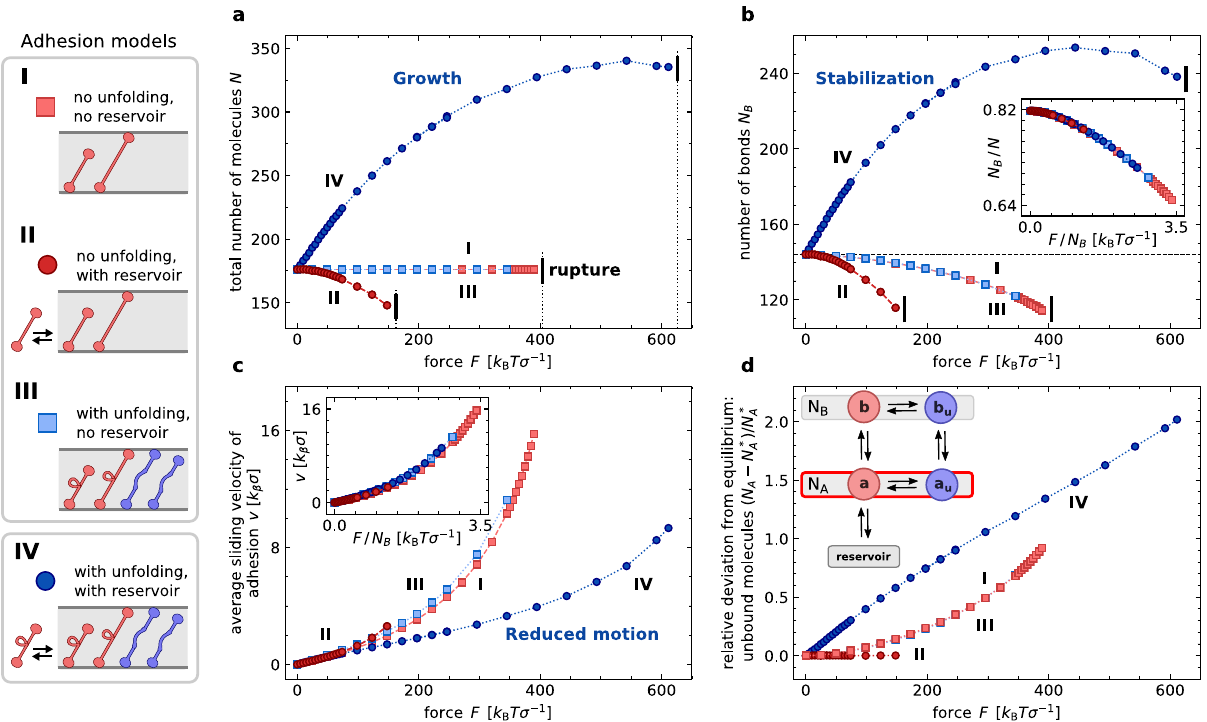
Fig. 2 Comparison of models I – IV for adhesions with and without molecule unfolding and reservoir exchange. Steady-state quantities are plotted until forces at which fi rst complete adhesion ruptures occur. a Averaged total number of molecules N . b Averaged overall number of bond N B formed by folded and unfolded molecules in steady state. Only model IV shows self-stabilization where the mean number of bonds increases initially with force. c Continuous rupture-rebinding transitions lead to a relative motion of the two planes bounding the adhesion. Self-stabilization reduces the motion. d Relative deviation of the average number of unbound molecules N A from equilibrium. Note the increased molecule accumulation in the unbound states for self-stabilization. See Supplementary Notes I for Fig. 2c. The inset in Fig. 2b shows that the bound fractions of molecules, N B / N , as a function of F collapse onto a single master curve for all models (I – IV). Hence, self-stabilization results from force-induced growth of the adhesion and not from changes of the rupture properties of individual molecules. This is the key difference to established catch-bond models, where individual molecules exhibit an increase of bond lifetime within limited force regimes.